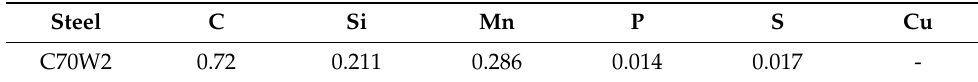
Table 1. The chemical composition of C70W2 steel, wt.